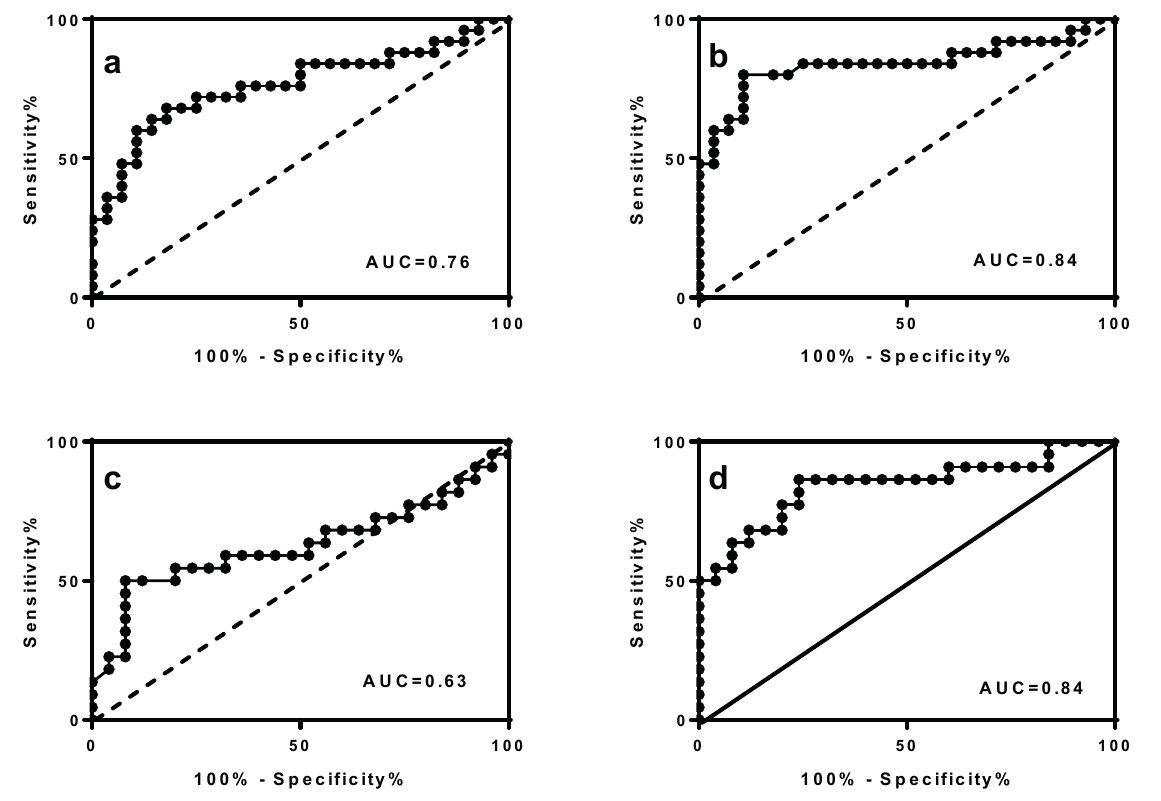
Figure 3: ROC curve of serum homocysteine and cystatin C as biomarker in prediction diagnosis of diabetic nephropathy (a: Serum homocysteine as biomarker in diagnosis of early stage diabetic nephropathy form simple type 2 diabetes mellitus; b: Serum cystatin C as biomarker in diagnosis of early stage diabetic nephropathy form simpleype 2 diabetes mellitus; c: Serum homocysteine as biomarker in diagnosis of clinical stage diabetic nephropathy form early stage diabetic nephropathy; d:Serum cystatin C as biomarker in diagnosis